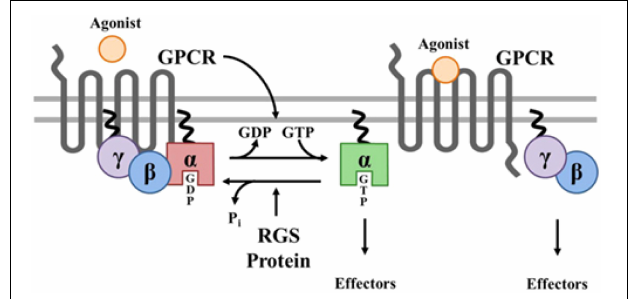
FIGURE 7 | Prenylation of α and γ G proteins (depicted as twisted lines) and canonical regulation of GPCR signaling by RGS proteins. Agonist binding to GPCRs induces a conformational change that facilitates the exchange of GDP for GTP on the α subunit of the heterotrimeric complex. Both GTP-bound G α in the active form and the released G βγ dimer can then go on to stimulate a number of downstream effectors. RGS proteins are GTPase accelerating proteins (GAPs) for G α , which function to terminate signaling through GPCRs by accelerating the intrinsic GTPase activity of G α and promoting re-association of the heterotrimeric complex with the receptor at the cell membrane. Borrowed from Stewart et al. (2012).